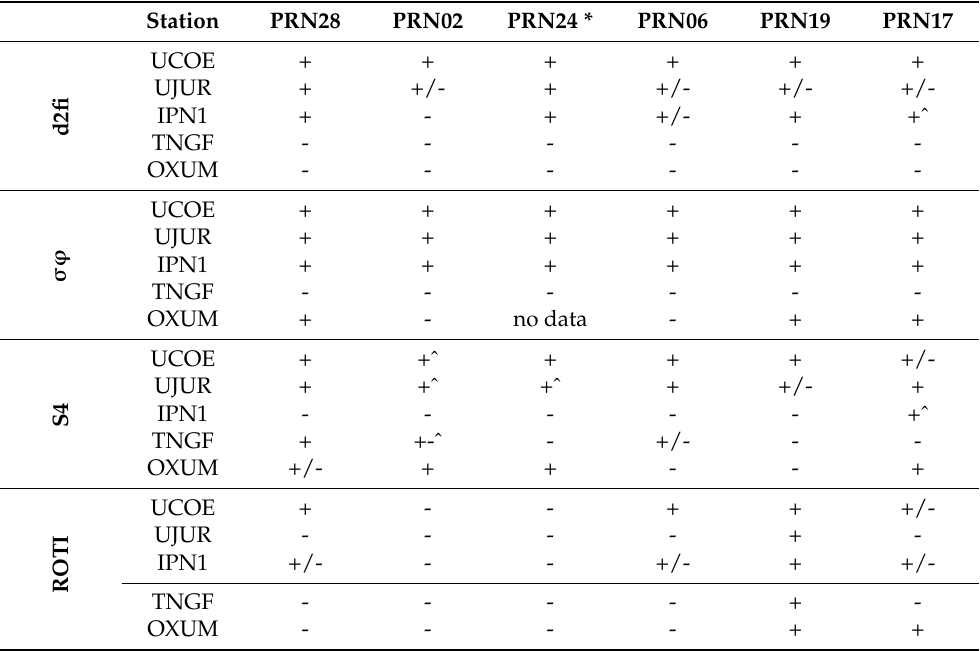
Table 3. Scintillation indices responses registered at different